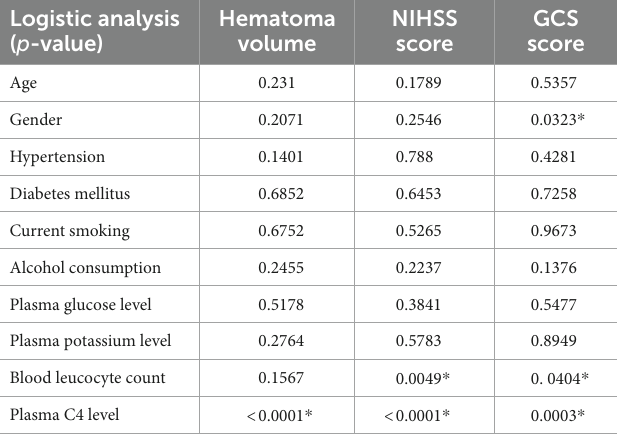
TABLE 2 Multivariate logistic regression analysis for risk factors of poor clinical outcomes after ICH. Logistic analysis ( p